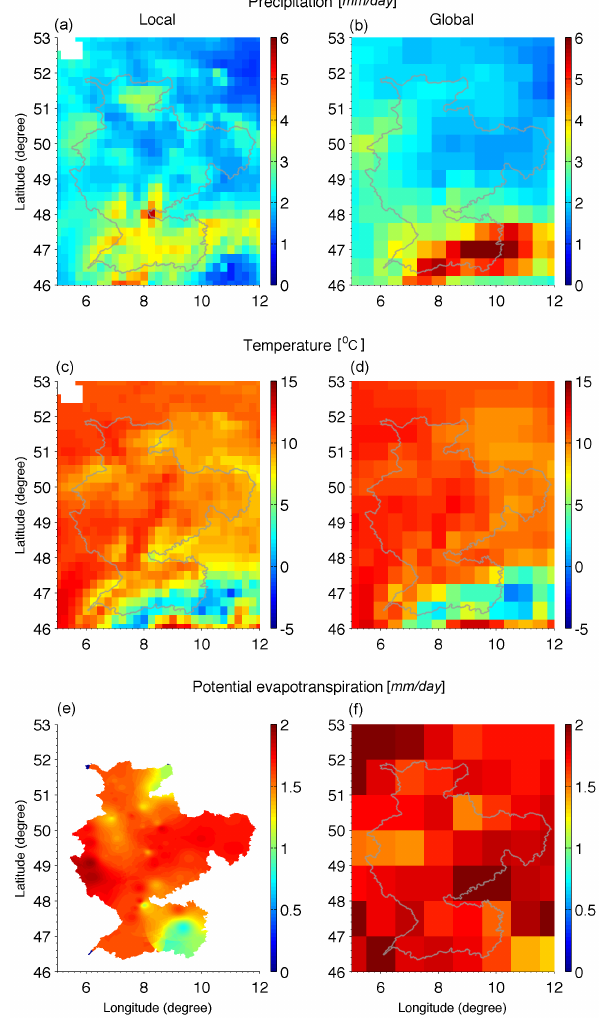
Figure 4. Mean daily precipitation, temperature, and potential evap- otranspiration in 2006 from the local (left panels) and global (right panels) forcing data